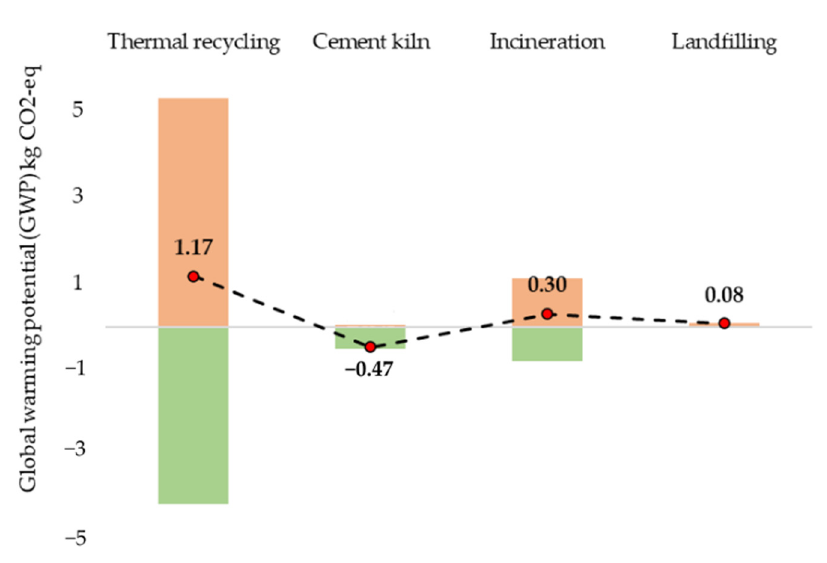
Figure 8. GWP of various GFRP waste disposal scenarios.